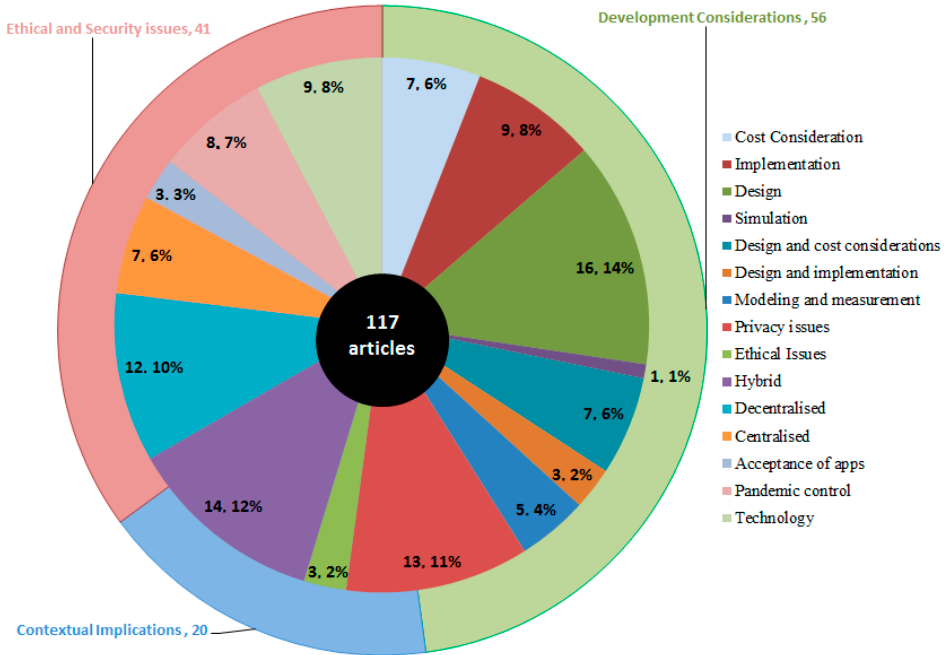
Figure 4. Analysis of the different issues focused on the included